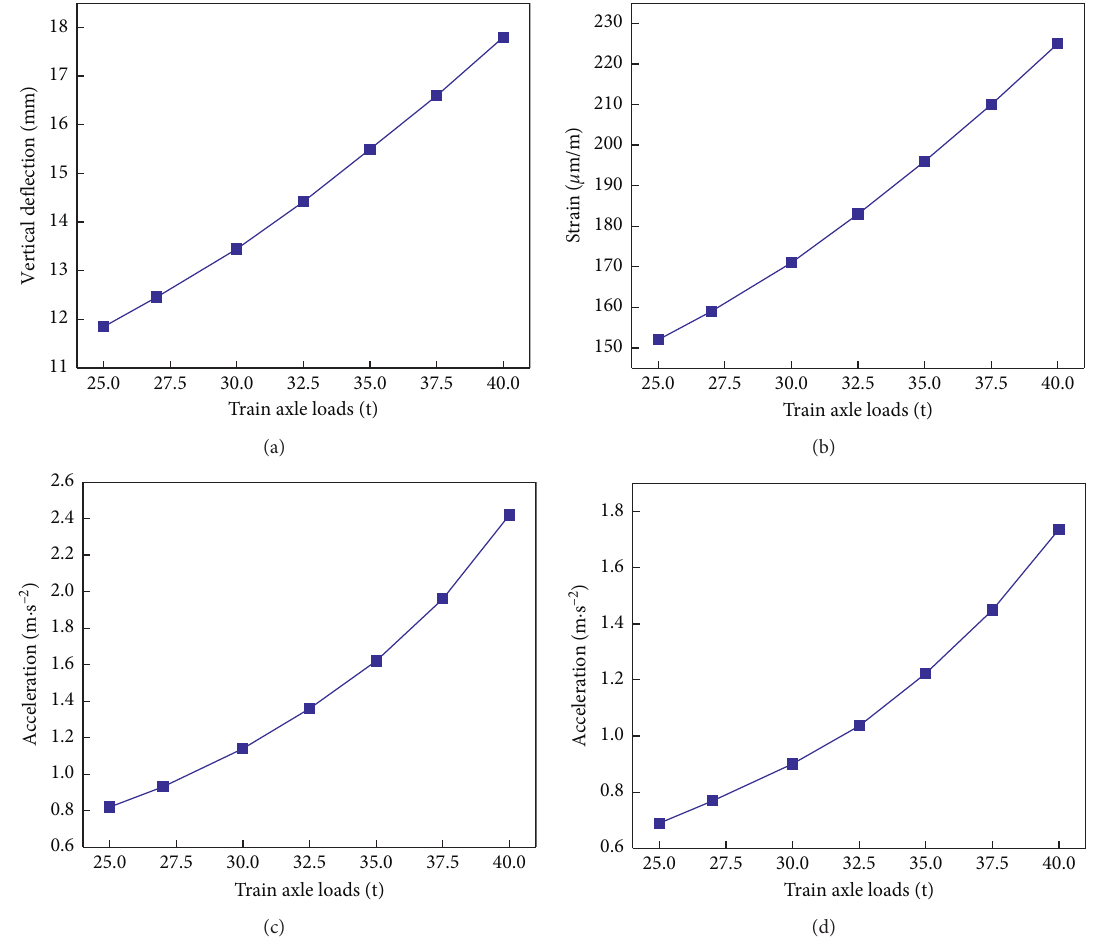
Figure 16: Maximum DR of the bridge girders’ mid-span section with different train axle loads: (a) vertical deflection; (b) strain; (c) vertical acceleration; (d) lateral